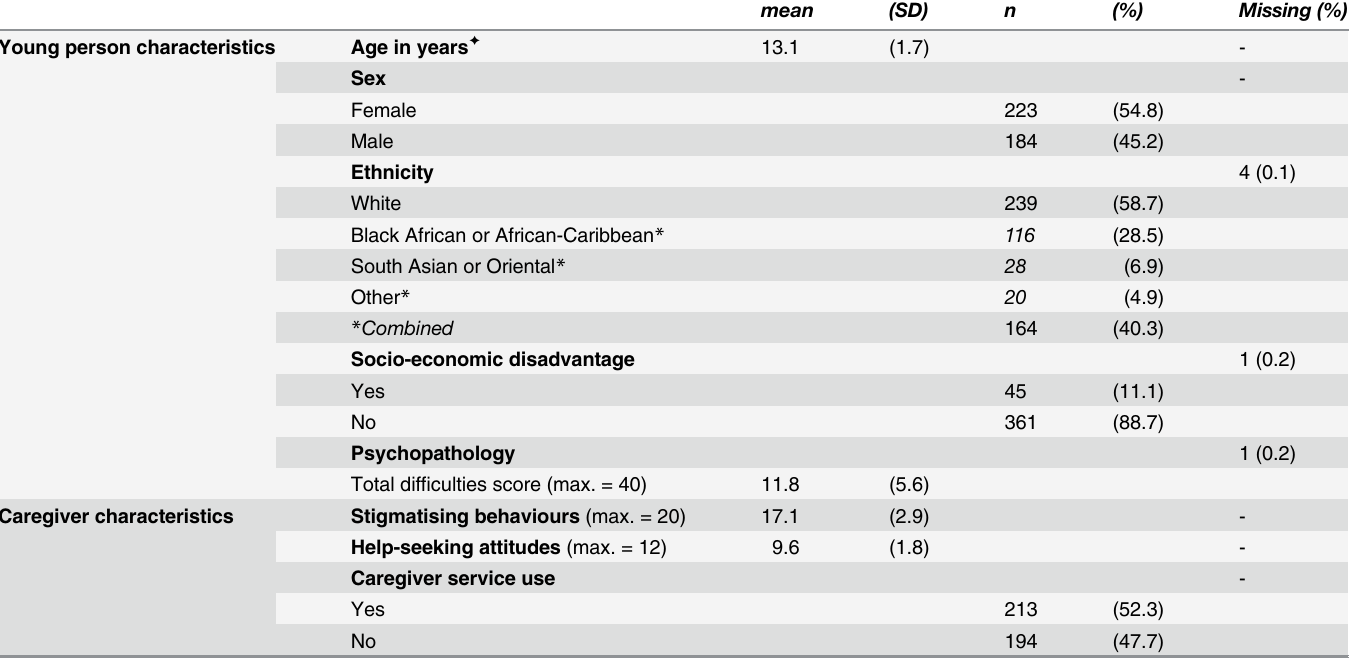
Table 1. Descriptive characteristics of young people and their primary caregivers (n =